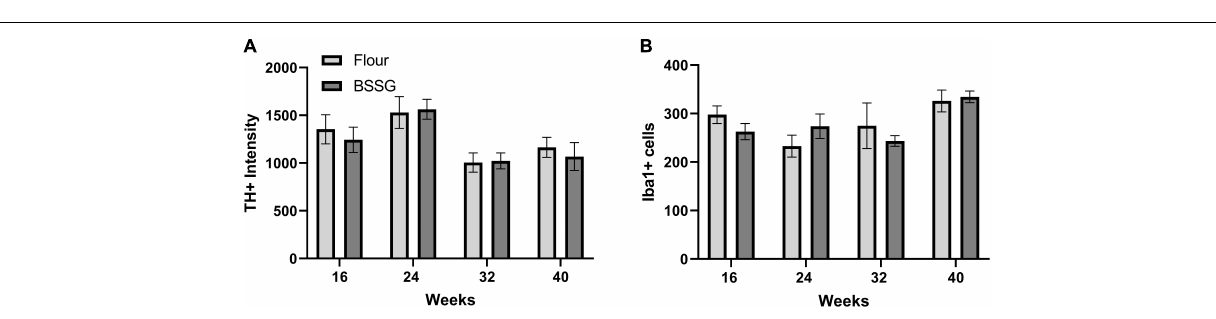
FIGURE 7 | Immunohistochemistry results. (A) Tyrosine hydroxylase (TH) immunofluorescence intensity and (B) Iba1 cell counts. Data are shown as means ± SEM n =